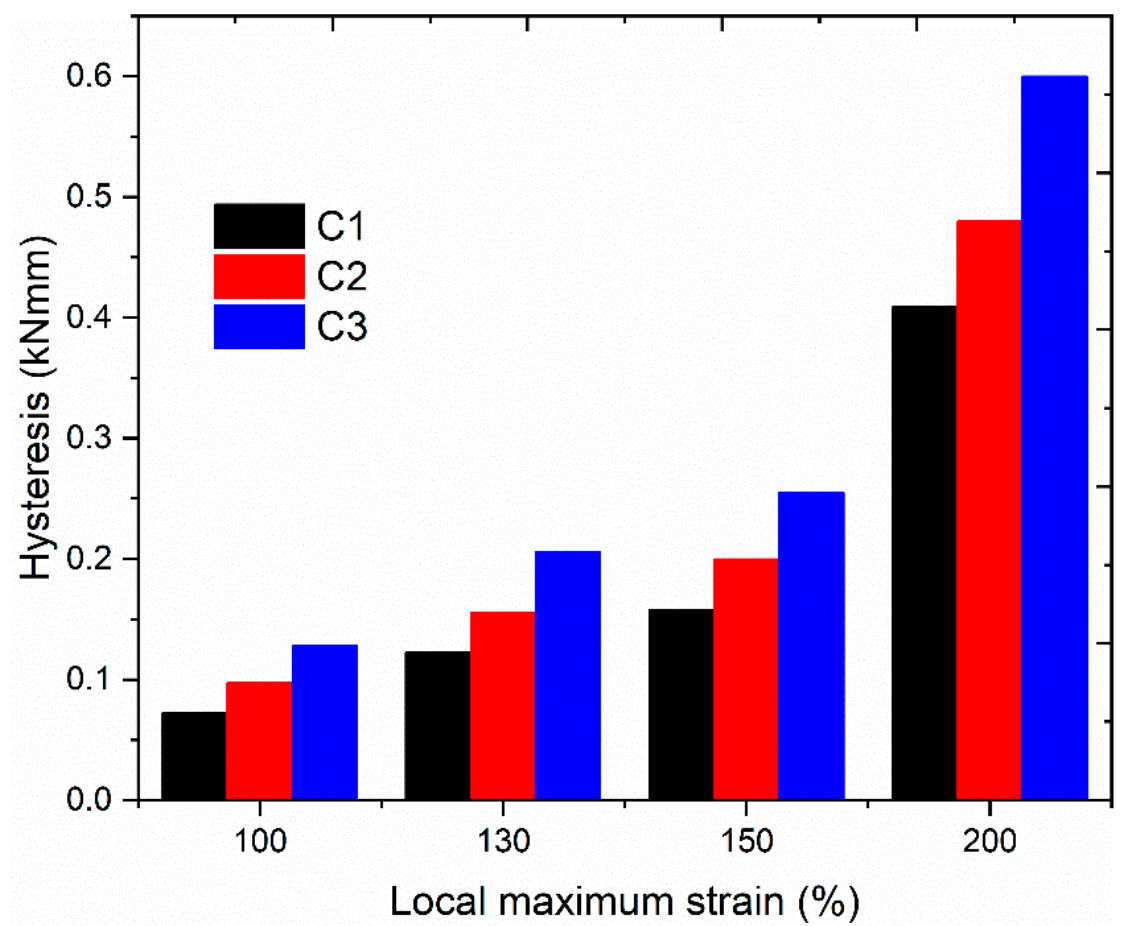
Figure 5. Measured hysteresis loss from compounds, including different silica fillers tested at different strain levels.